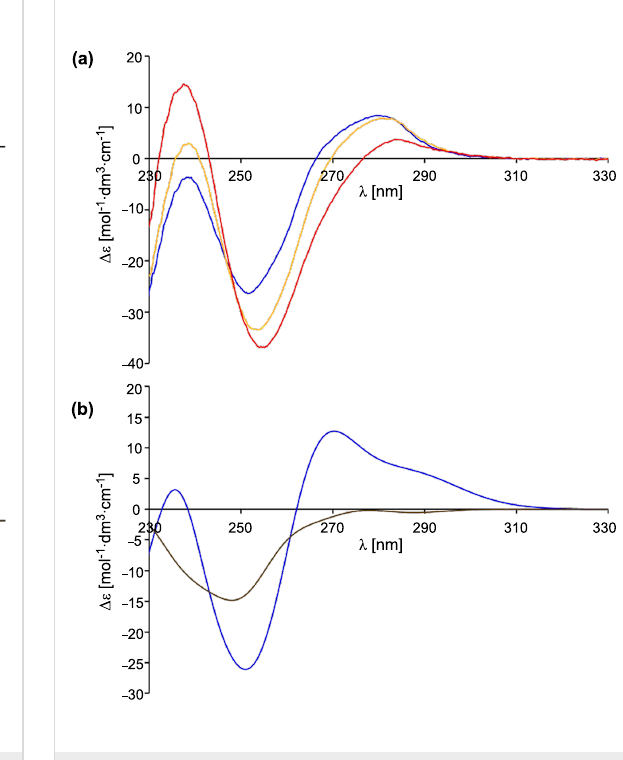
Figure 7: (a) CD spectral change of pyridine switch 10 (blue) in di- chloromethane (c = 5.6 × 10 –5 M) at 20 °C upon addition of 1 (yellow) and 20 equiv TFA ( 11 , red). (b) Calculated spectra of ( M )- 10 (blue) and ( P )- 10 (brown) by using TD-DFT-B3LYP/6-31G*.